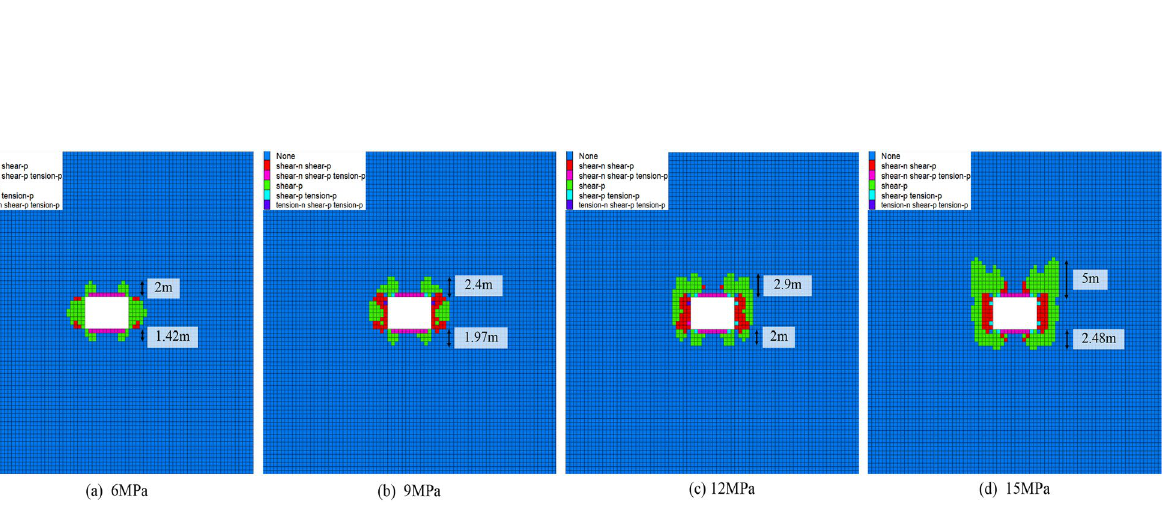
Figure 5. Failure of surrounding rock under different disturbance